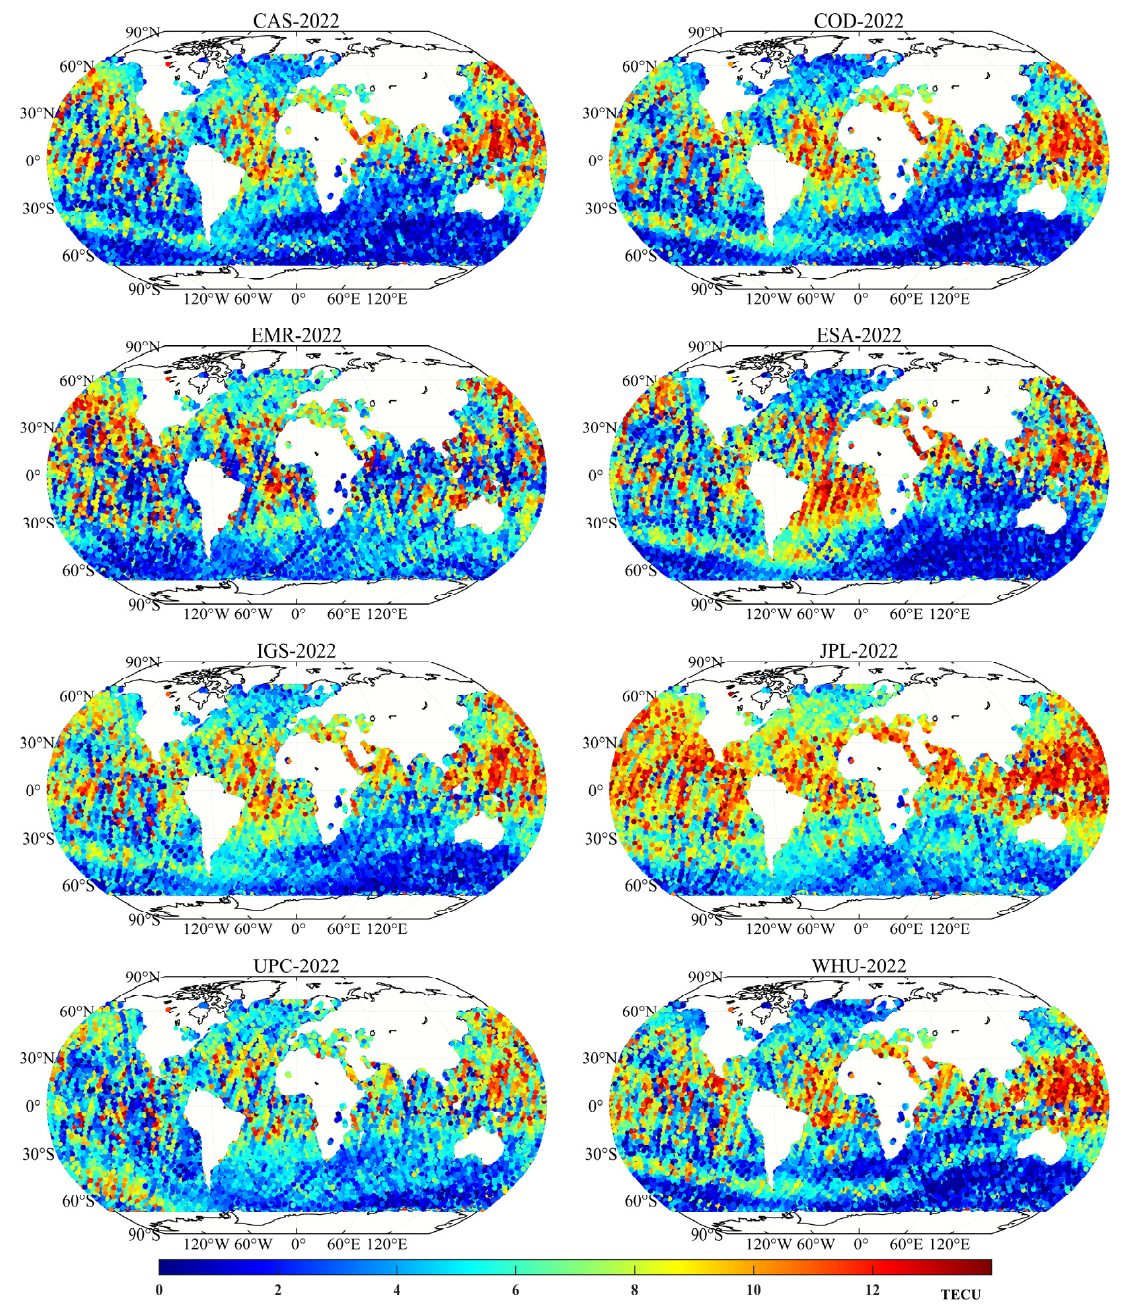
Figure 8. Bias distribution of different GIMs with Jason-3 altimetry satellites in 2022.